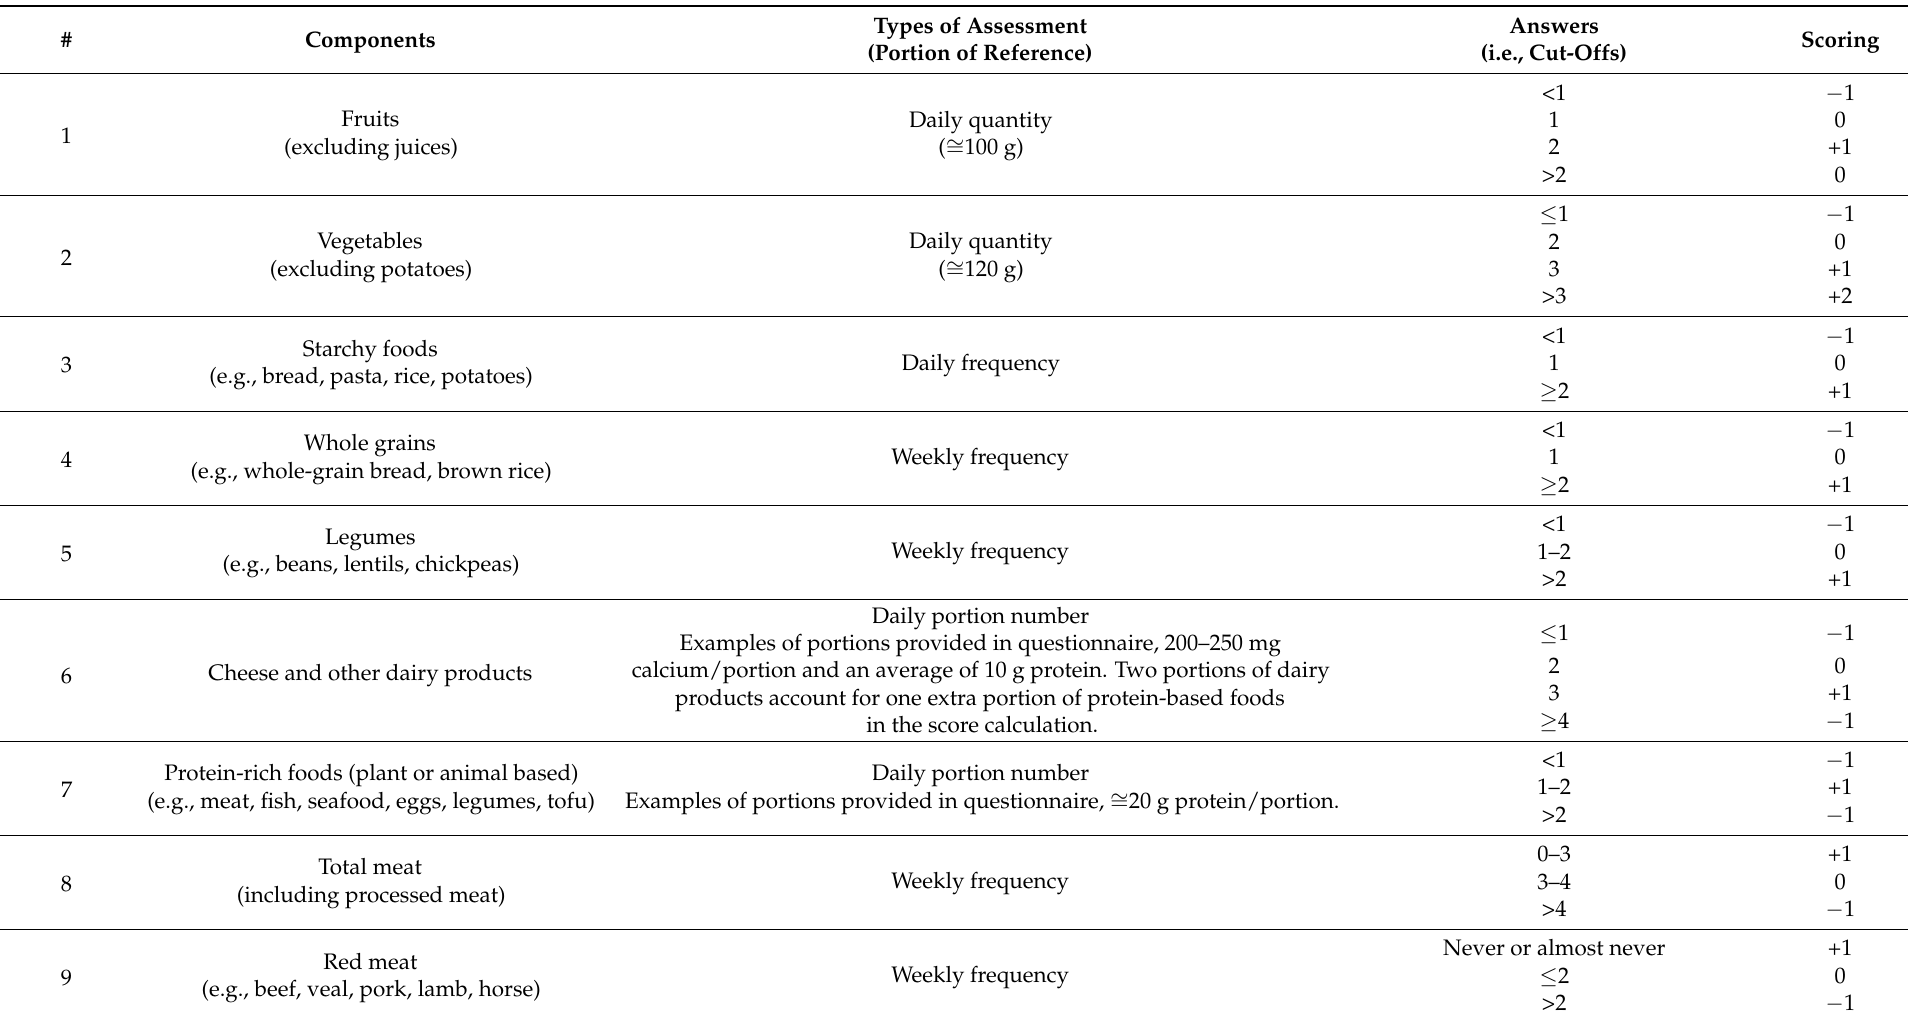
Table 1. Description of SCASA (Score d’Alimentation Saine) items and scoring